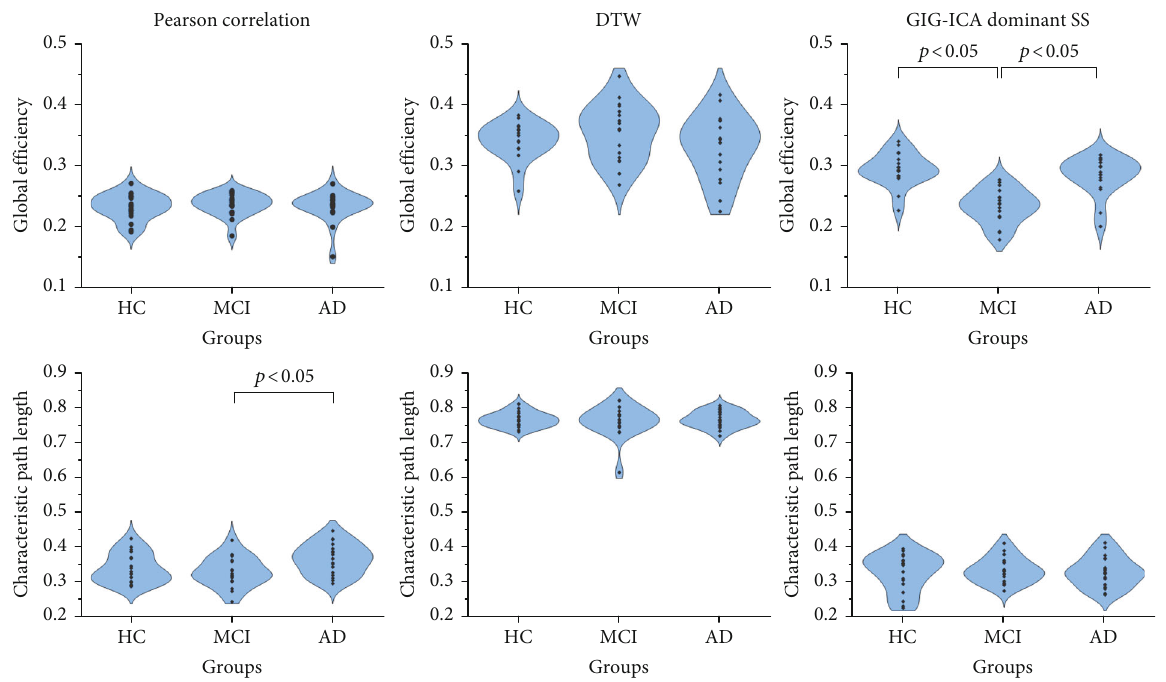
Figure 3: Violin plots of ANCOVA analyses on network-level topological metrics, including global e ffi ciency and characteristic path length. No signi fi cant di ff erences were found in rs-FC networks constructed with DTW, in terms of the both metrics. As for Pearson correlation, only MCI and AD groups were signi fi cantly identi fi ed according to the metric of characteristic path length. In FC networks constructed with GIG-ICA, signi fi cant di ff erences between HC, AD, and MCI groups were found in terms of global e ffi